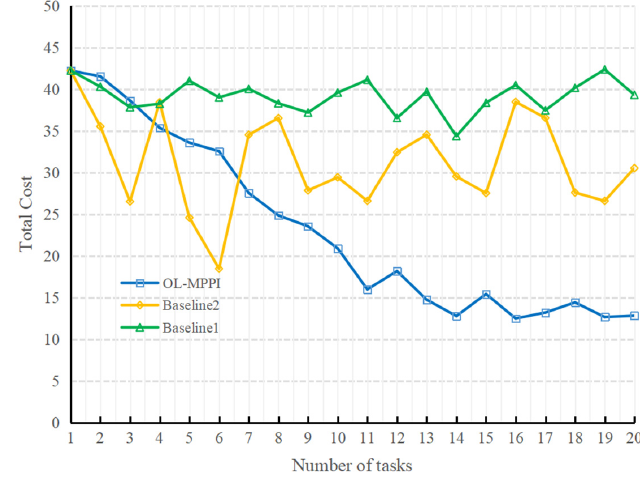
Figure 11. Total cost of different planning methods.